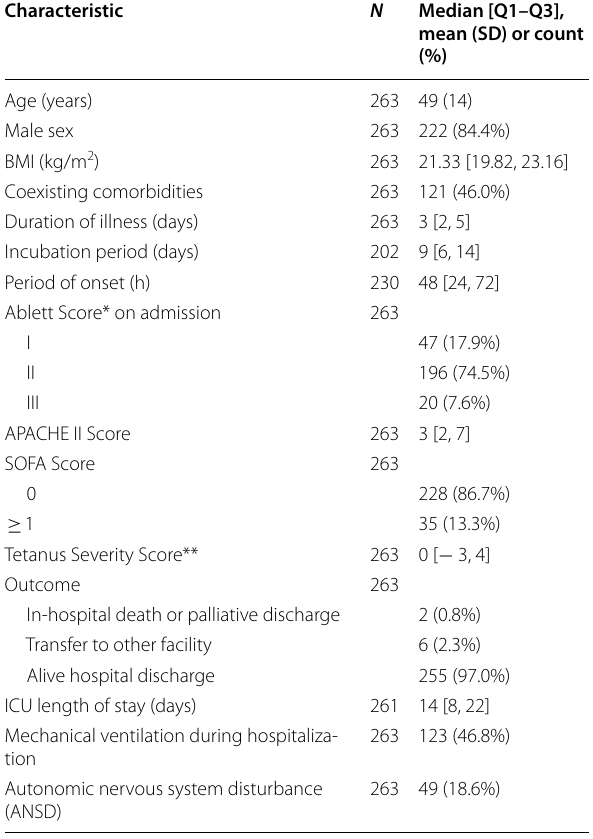
Table 1 Descriptions of the demographic and clinical features of tetanus